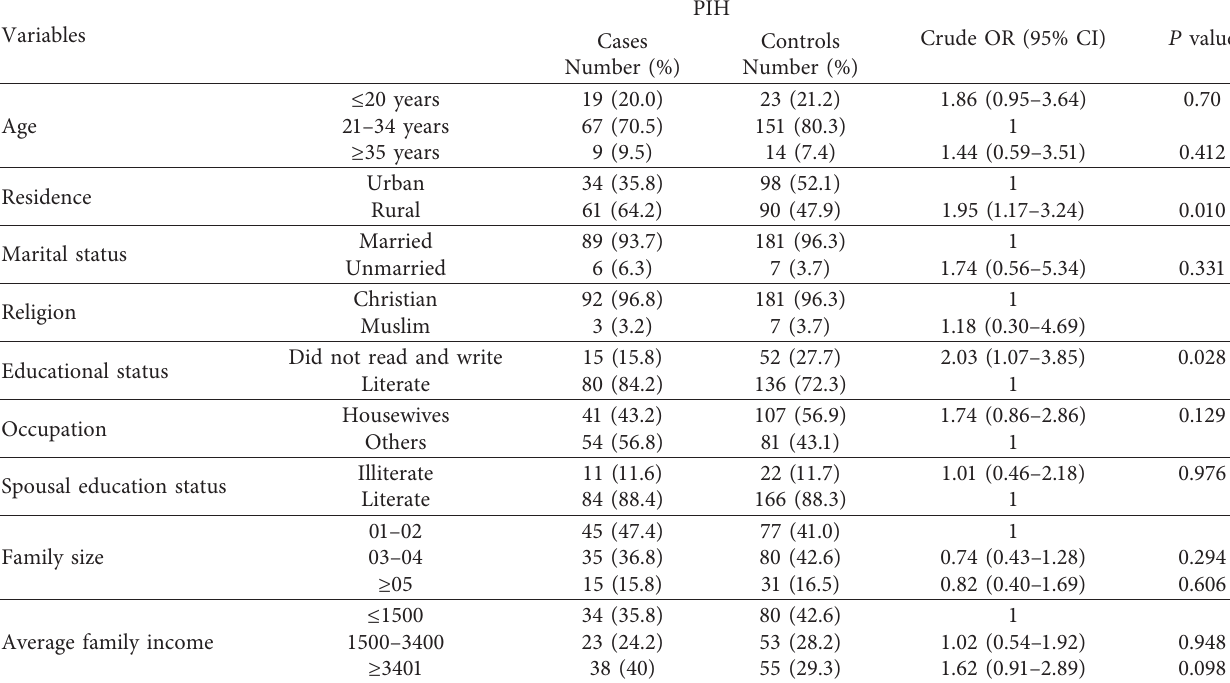
Table 3: Sociodemographic characteristics of mothers with and without hypertensive disorders of pregnancy-induced hypertension in Wolaita zone, southern Ethiopia, 2020.